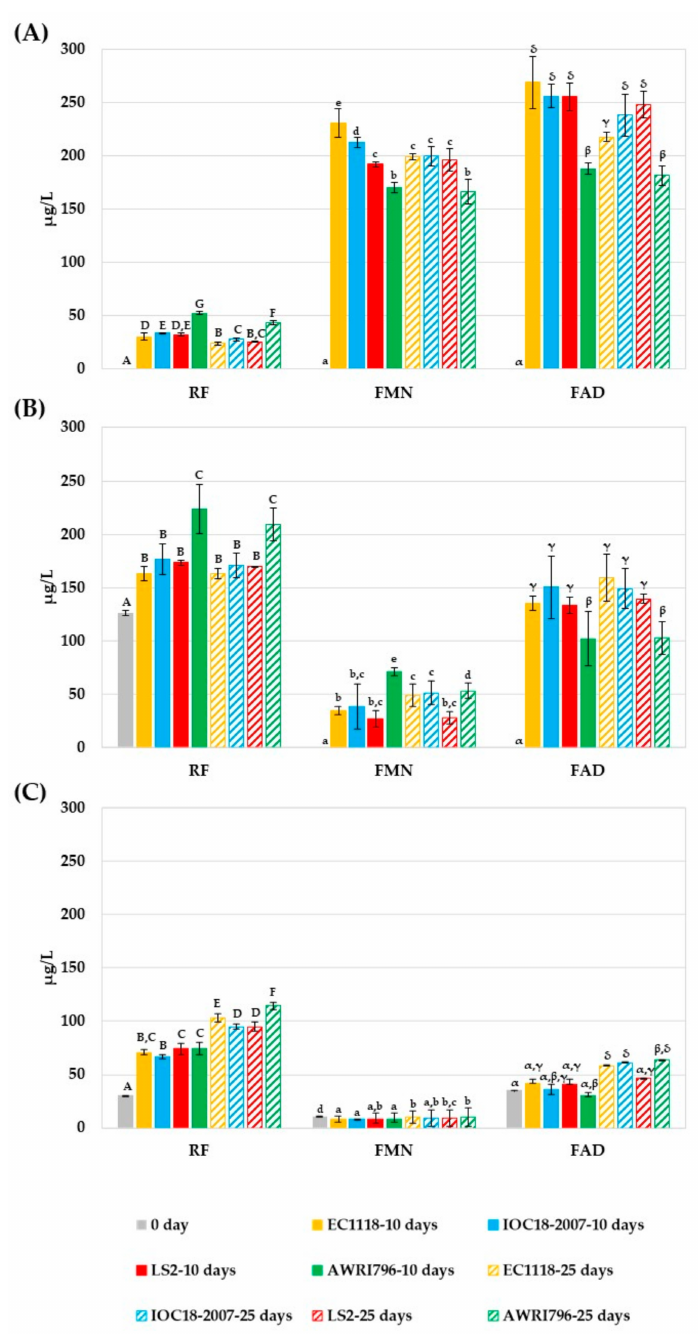
Figure 3. Extracellular FDs released during the fermentation processes: ( A ) SMV; ( B ) SMV+RF; ( C ) Must. Bars in grey describe the concentration at the starting point; the strains are represented by a specific color: EC1118 (yellow); IOC18-2007 (light-blue); LS2 (red); AWRI796 (green). The full-colored bars identify the concentrations after 10 days of fermentation, while the dashed ones show the concentrations after 25 days. The results are reported as average data of three replicates, and the error bars indicate the standard deviations. Capital, lowercase, and greek letters are used for RF, FMN, and FAD content, respectively. Different letters correspond to significant differences ( p <